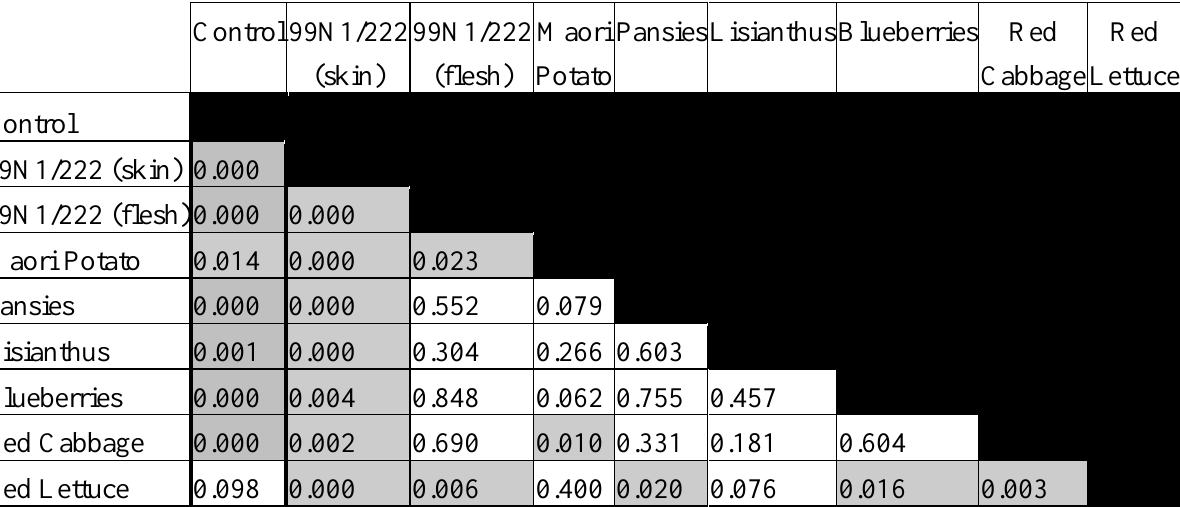
Table 2 . P-values determined from unpaired t-tests for tail extent moment in the untreated group. Shaded boxes represent significant differences (p 